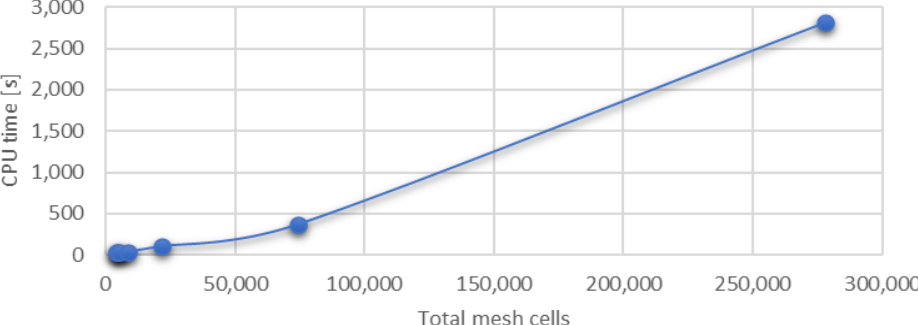
Figure 10. Time of central processing unit (CPU) versus total number of mesh cells for the geometry with upper air inlet and outlet.